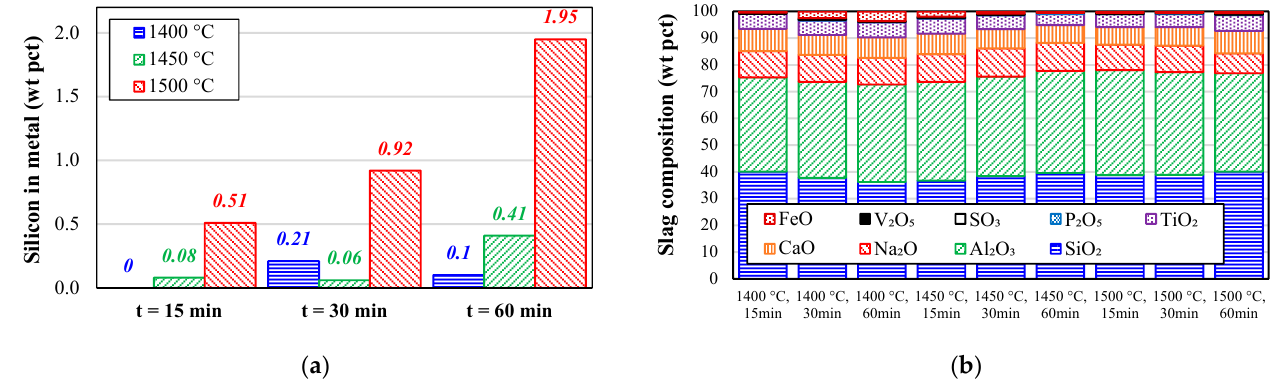
Figure 4. The effects of temperature and time at 7%carbon addition on ( a ) silicon in metal; and ( b ) slag composition.